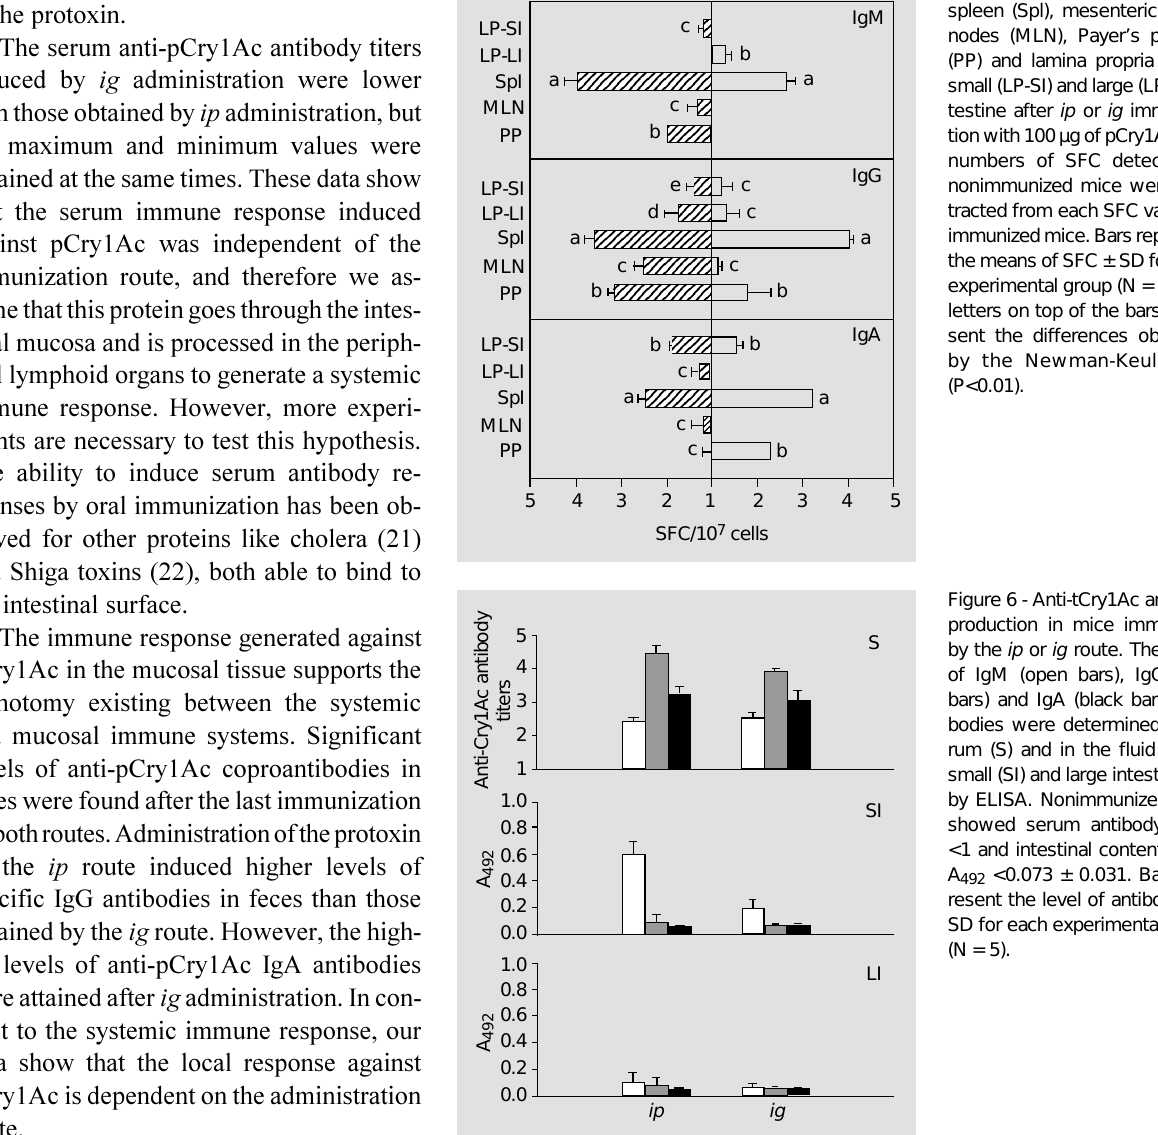
Figure 5 - Anti-pCry1Ac anti- body-producing cells (SFC) in the spleen (Spl), mesenteric lymph nodes (MLN), Payer’s patches (PP) and lamina propria of the small (LP-SI) and large (LP-LI) in- testine after ip or ig immuniza- tion with 100 µg of pCry1Ac. The numbers of SFC detected in nonimmunized mice were sub- tracted from each SFC value for immunized mice. Bars represent the means of SFC ± SD for each experimental group (N = 5). The letters on top of the bars repre- sent the differences observed by the Newman-Keuls test (P<0.01).